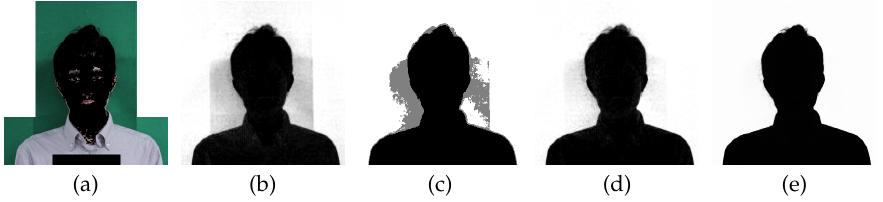
Figure A1. Image matting with region growing. (a) Initial specification of the background (white color) and the foreground (black color). (b) is the result after the first iteration, and (c) is the result after region growing. (d) is the result after the second iteration, and (e) is the result after region